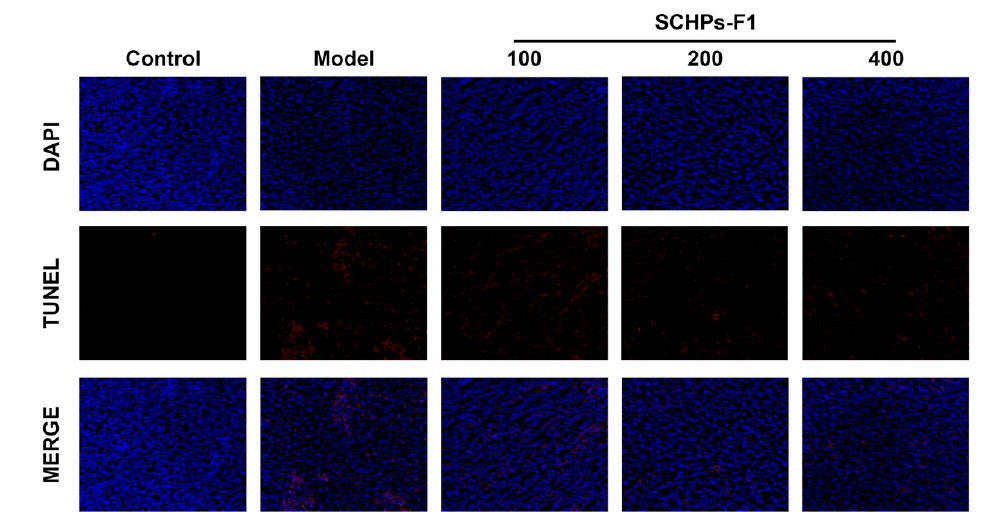
Figure 6. E ff ects of SCHPs-F1 on apoptosis in kidney tissues of CTX-treated mice assessed by TUNEL assay ( × 200 magnification). The top panels show representative images of 4,6-diamidino-2-phenylindole (DAPI)-stained cell nuclei (blue). The middle panels show representative images of TUNEL-positive cells labeled with red fluorescent dye Alexa Fluor 640. The bottom panels show the merged fluorescence